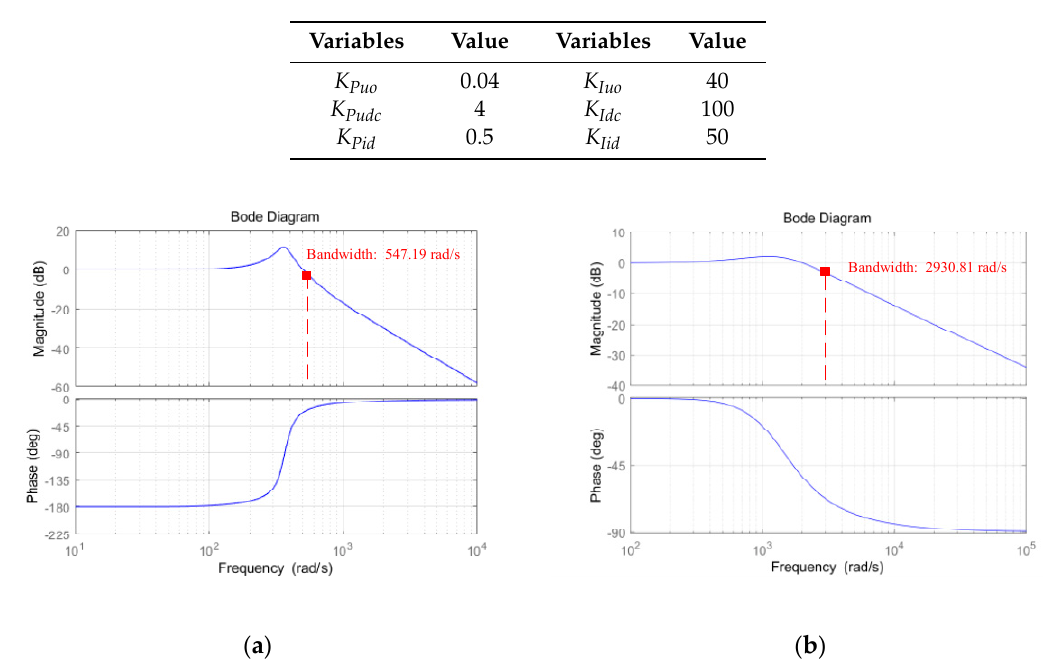
Figure 7. Current response Bode diagrams under independent control: ( a ) current response of the high-voltage DC (HVDC) link; ( b ) current response of the low-voltage DC (LVDC) link.